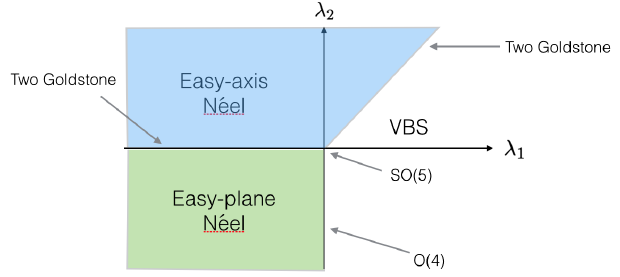
FIG. 2. Phase diagram near the SO(5)-invariant fixed point with perturbation of the form λ 1 ð X 11 þ X 22 Þ þ λ 2 X 55 .